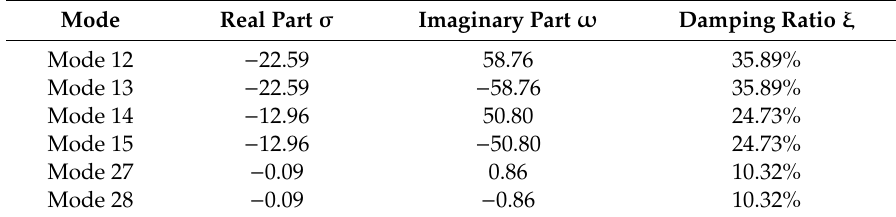
Table 7. Oscillatory modes, operating point 2, SVC disconnected.